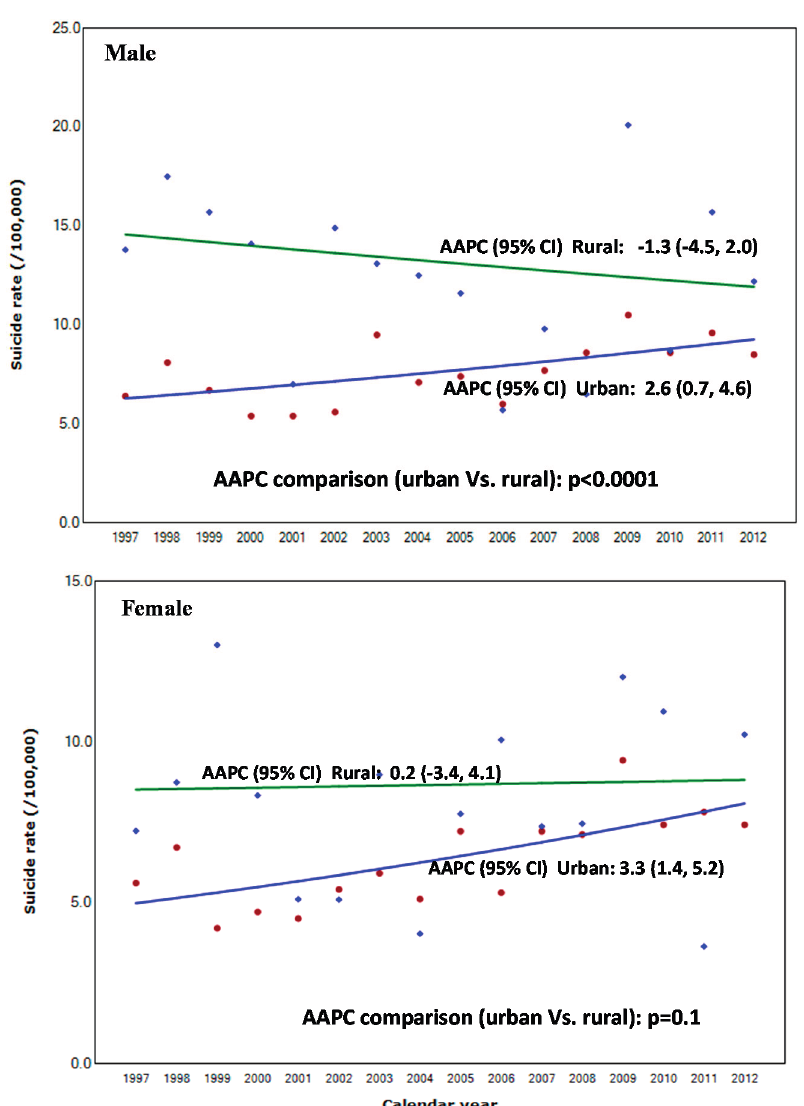
Figure 2. Suicide rate and annual average percent change (AAPC) according to urbanity among adolescents, 15–19 years of age by gender in Korea, 1997–2012; Model selection and p -value of AAPC comparison test estimated using Monte Carlo Permutation method